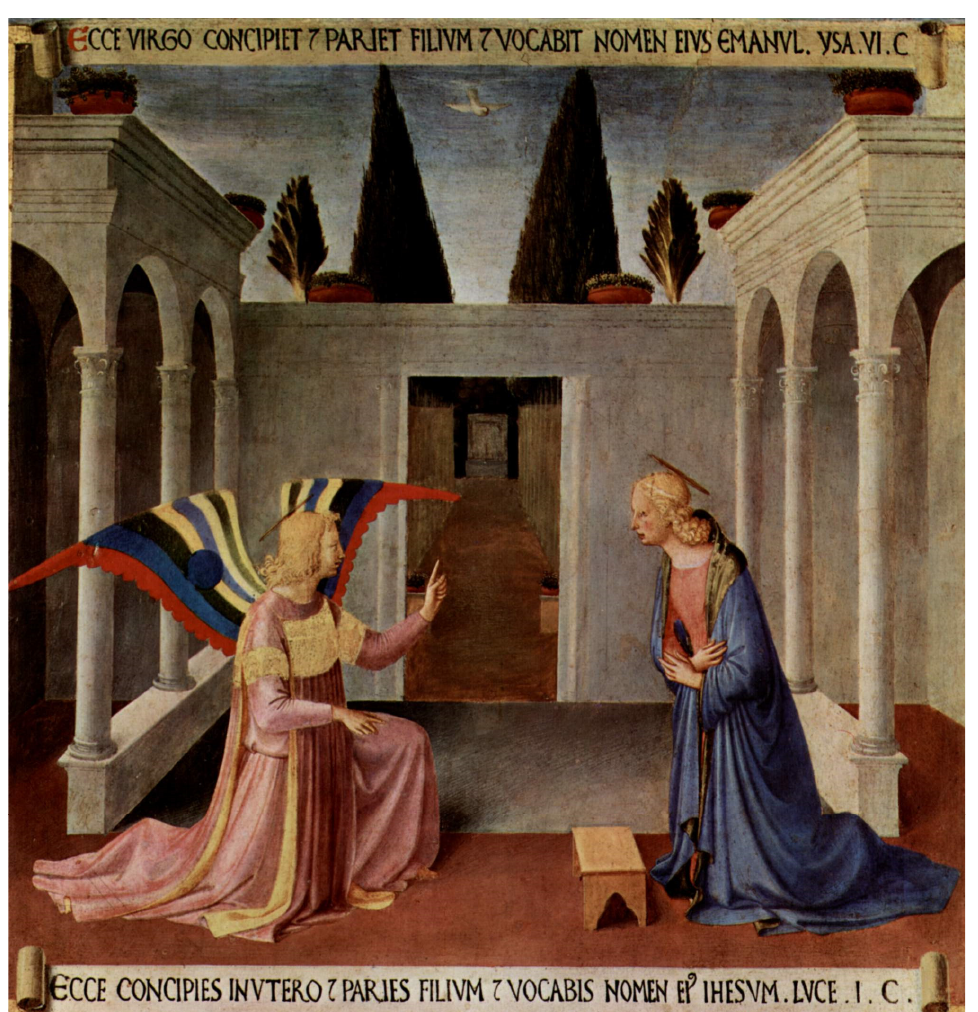
Figure 3. Fra Angelico, The Annunciation , c. 1451–1453. A scene from the Armadio degli Argenti , Museo Convento di San Marco, Florence. Fra Filippo Lippi (1406–1469) painted this Annunciazione delle Murate , 1443, from the